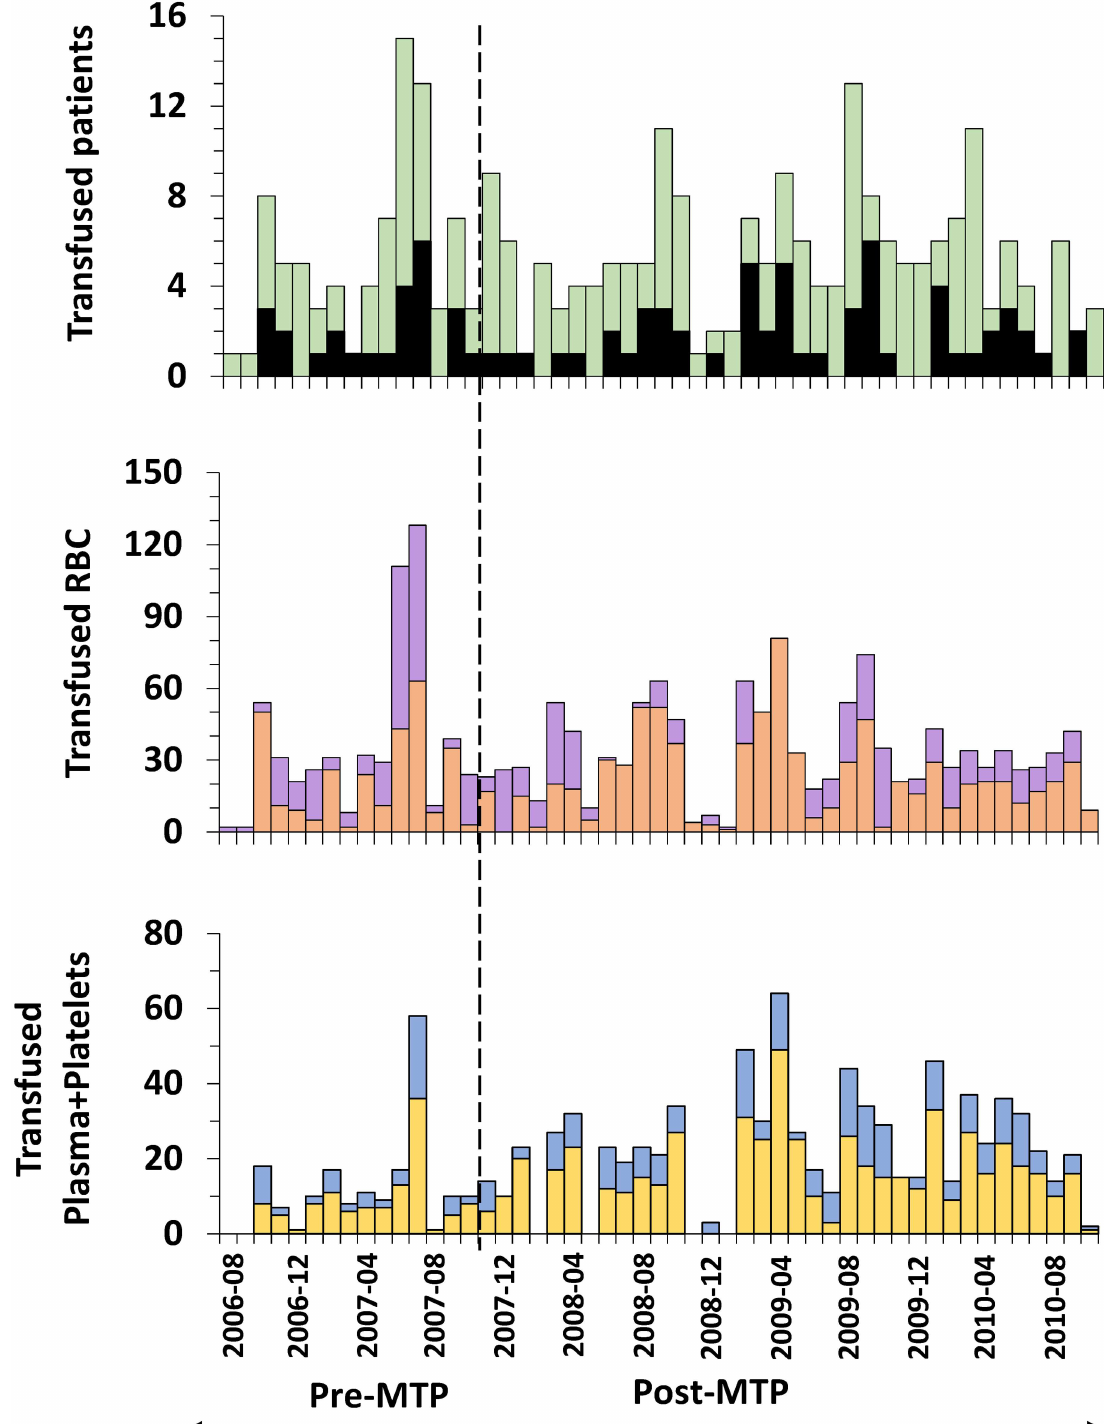
Fig 1. Transfused casualties and product use per month at MBTK. MTBK indicatesMultinational Base Tarin Kowt, RBC ; red blood cells, MTP : Massive TransfusionProtocol, nr : number, MT : massive transfusion, EC : Erythrocyte Concentrate. Upper panel: black bars : nr of MT patients, green bars : nr non-MT patients. Middle panel: orange :sum of thawed deglycerolized RBC units, purple :sum of EC units. Lower panel: yellow :sum of frozen plasma units, blue : sum of (plasmaof) frozen plateletsunits.